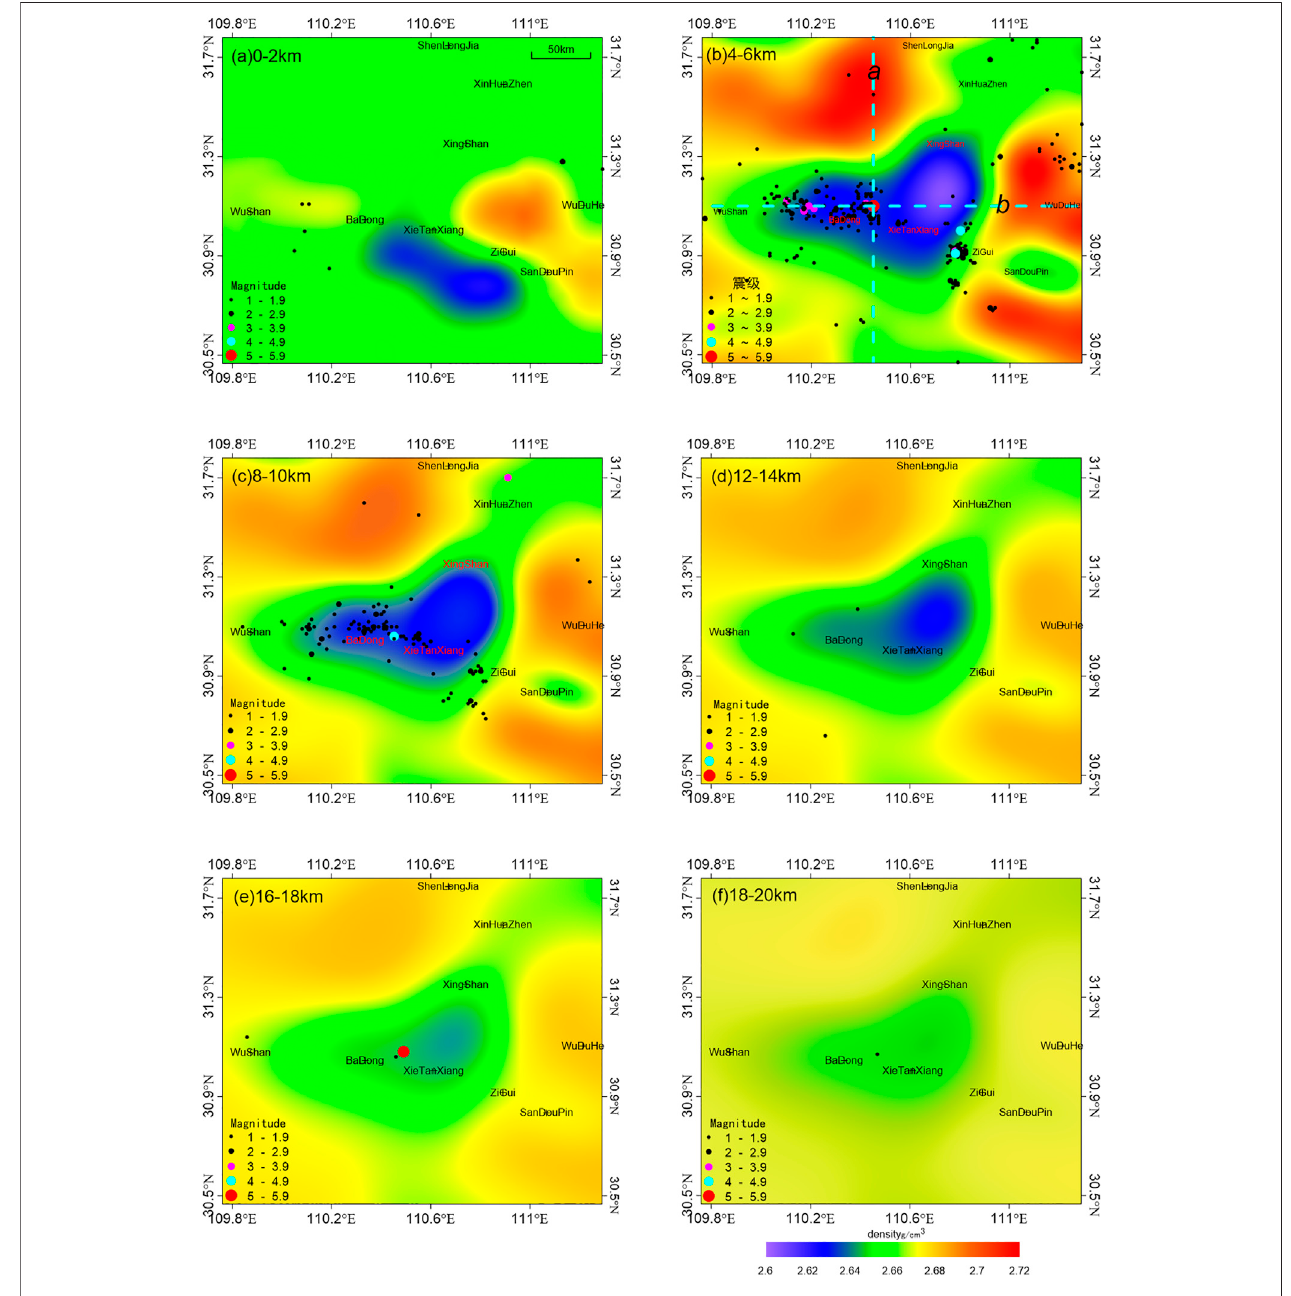
FIGURE 5 | Badong – Zigui region underground density distribution: (A) 0 – 2 km, (B) 4 – 6 km, (C) 8 – 10 km, (D) 12 – 14 km, (E) 16 – 18 km, and (F) 18 – 20 km.